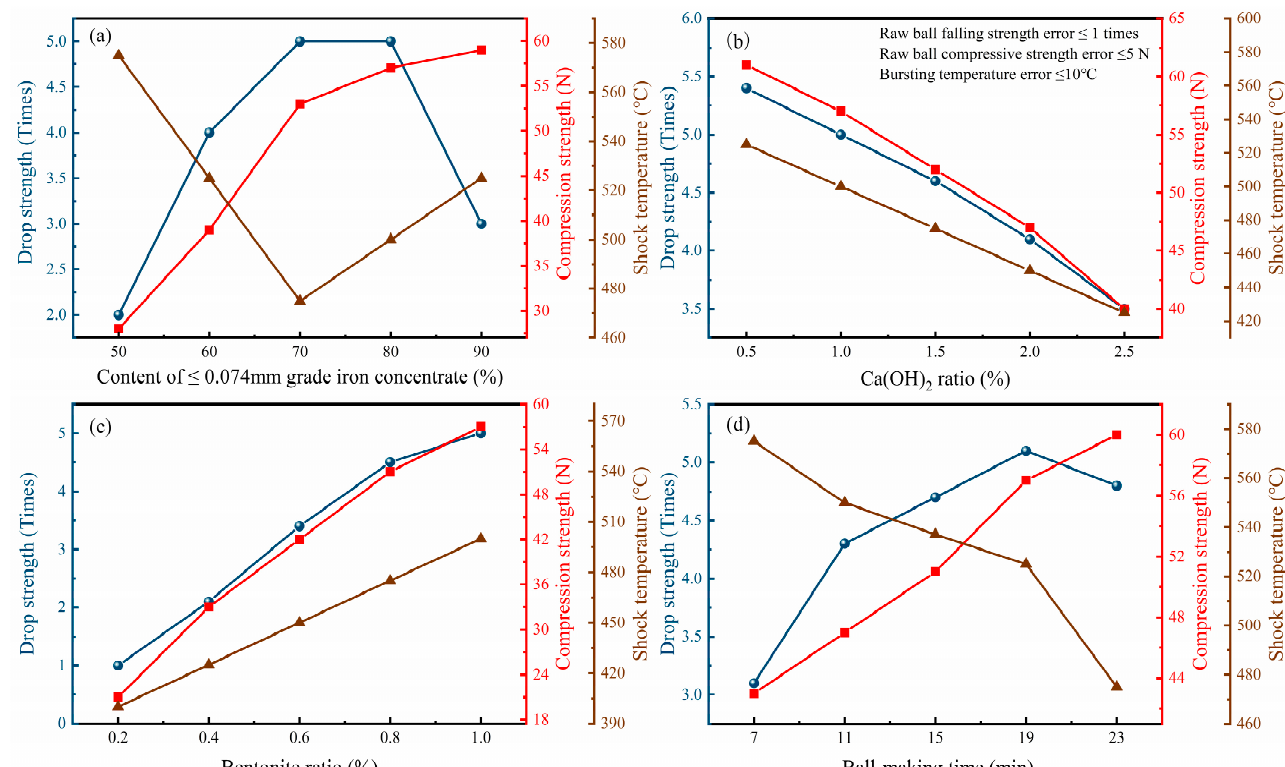
Figure 3. Effect of pelletizing factors on raw ball drop strength, compressive strength, bursting tem- perature. ( a ) the effect of iron concentrate -0.074mm particle size ratio; ( b ) the effect of Ca(OH) 2 ratio; − 0.074 mm particle size ratio; ( b ) the effect of Ca(OH) 2 ( c ) the effect of bentonite ratio; ( d ) the effect of ball-making time. temperature. ( a ) the effect of iron concentrate ratio; ( c ) the effect of bentonite ratio; ( d ) the effect of ball-making